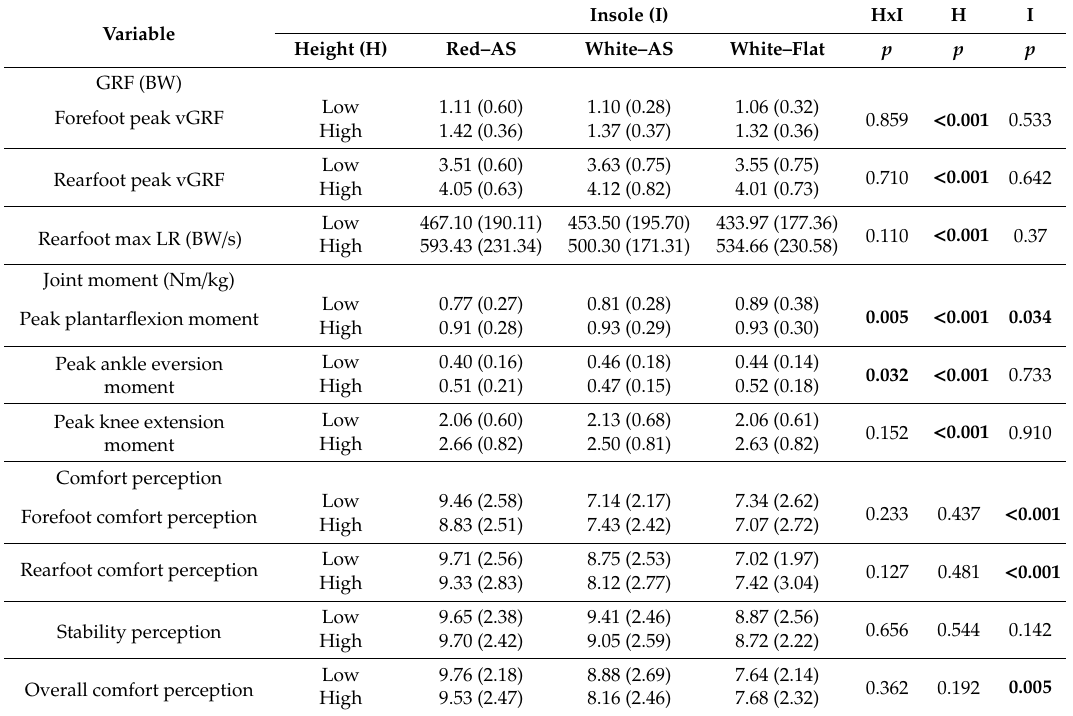
Table 2. Ground reaction force (GRF), joint moment and comfort perception of three insole conditions during the two landing heights.